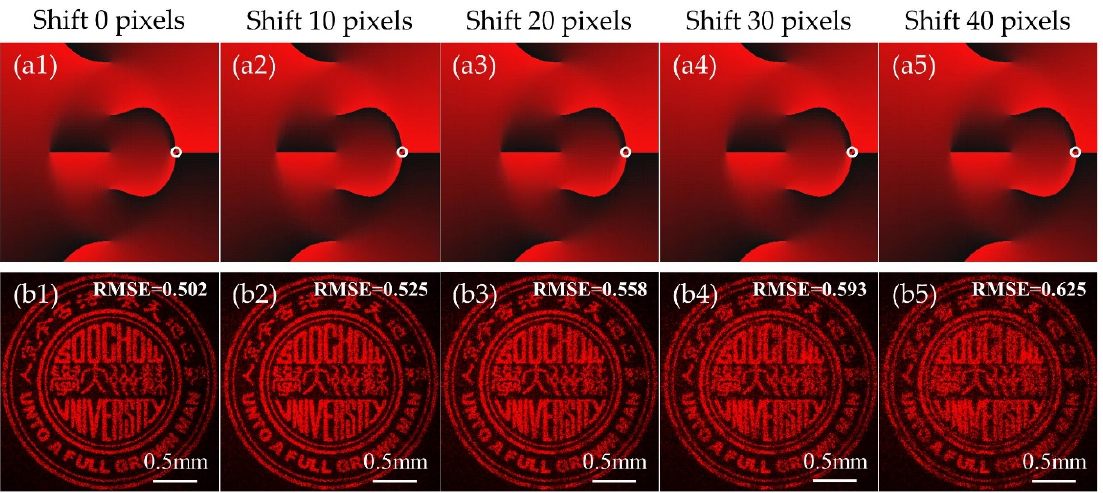
Figure 8. Experimental results increasing lateral misplacement of the Soochow University logo CGH with the composite OAM beam ( p 1 , l 1 ) = (1, 1) and ( p 2 , l 2 ) = (1, 3). ( a1 – a5 ) The phase distributions of different lateral misplacements, the white circle indicates the position of one of the phase singularities. ( b1 – b5 ) Experimental far-field images for different lateral misplacements. A pixel is 12.5 µ